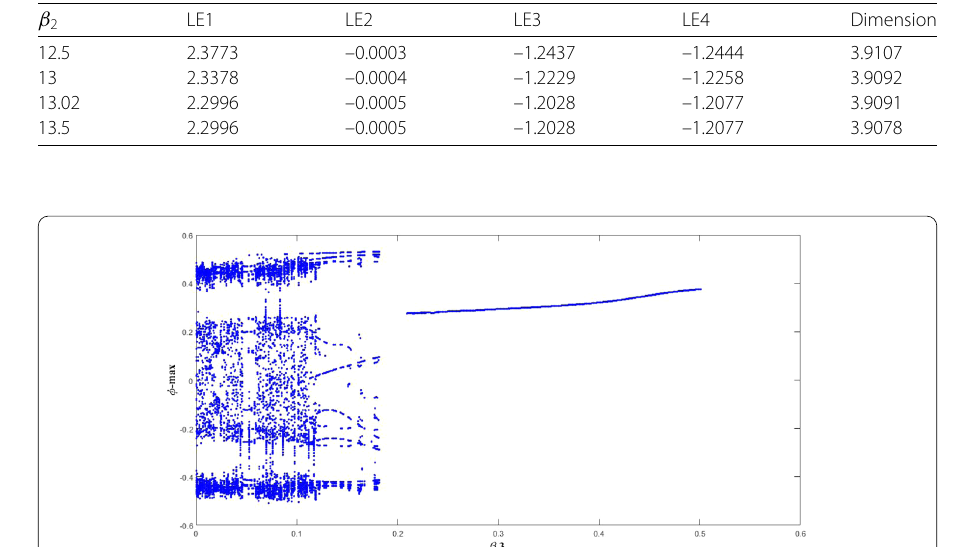
Figure 9 Bifurcation diagram due to variation of the parameter β 3 in